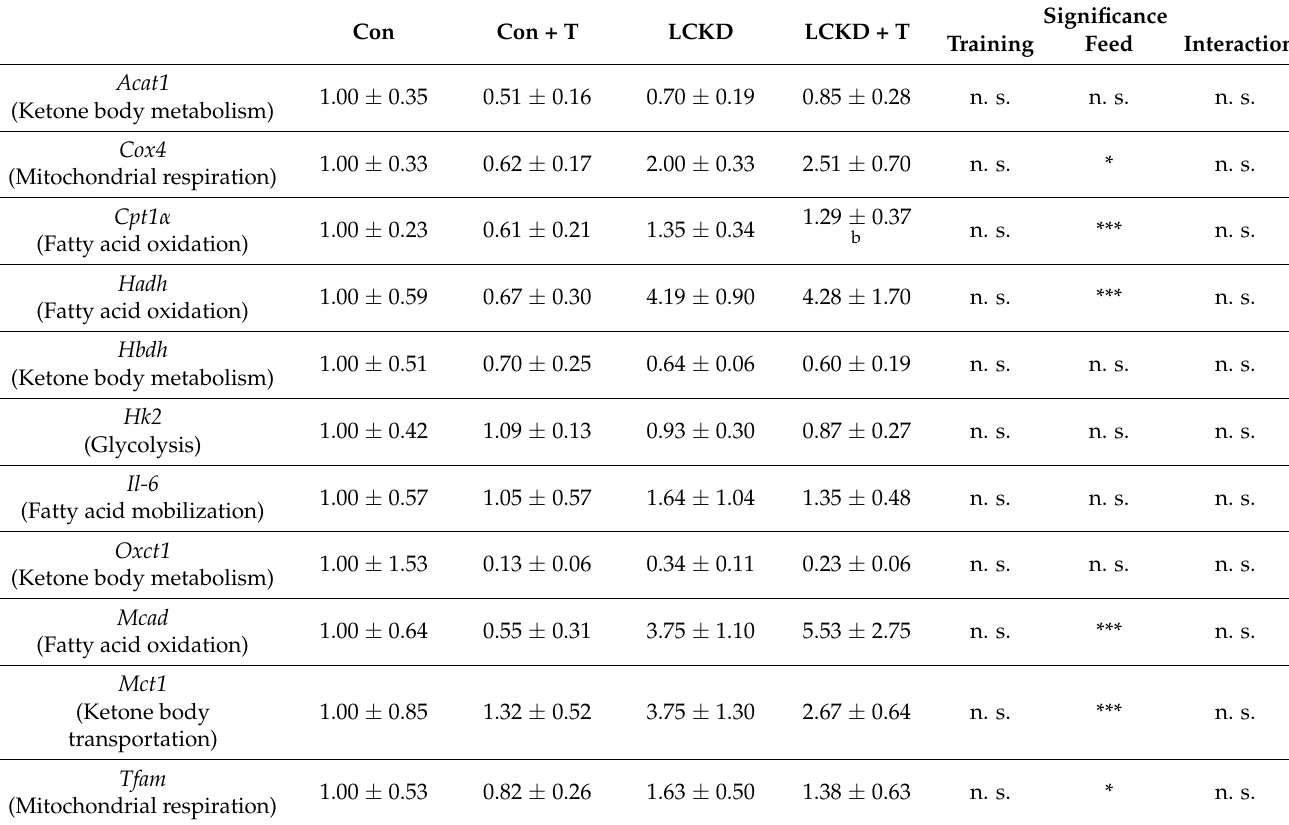
Table 10. The effect of LCKD and/or training on soleus muscle gene